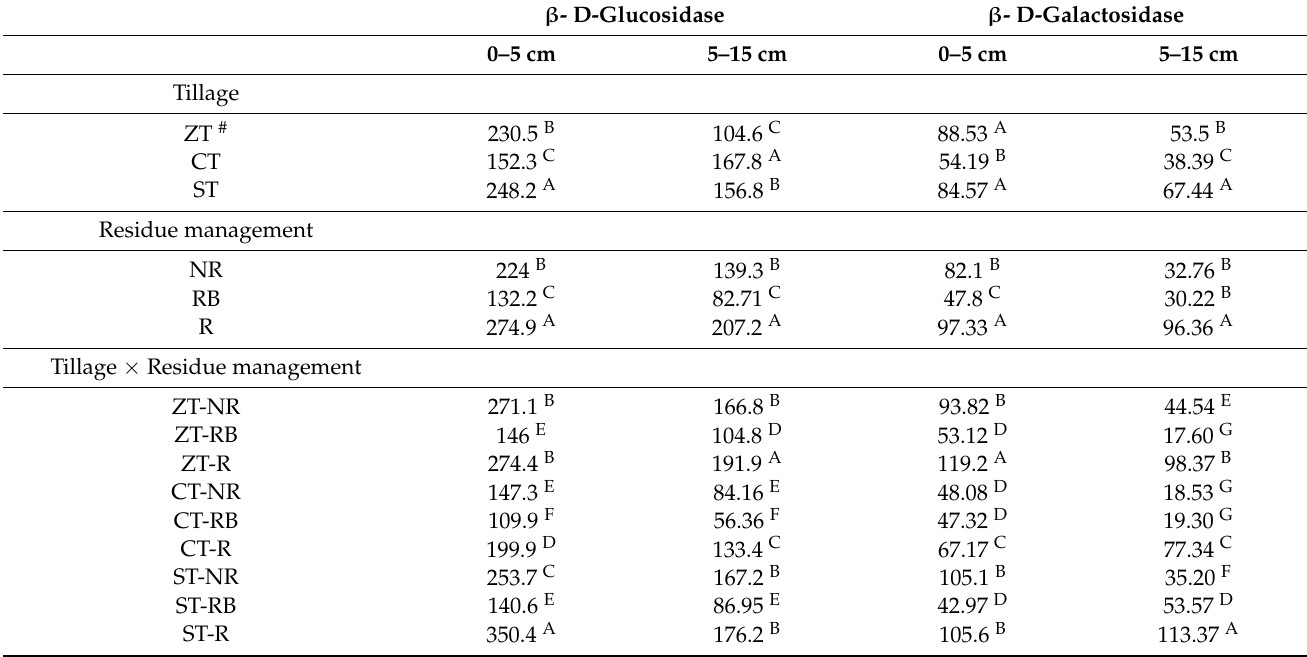
Table 4. Soil β - D-glucosidase and β - D-galactosidase activities ( µ g g − 1 h − 1 ) as influenced by 18 years of tillage and residue management under a rice–wheat cropping system in an Inceptisol in 0–5 cm and 5–15 cm